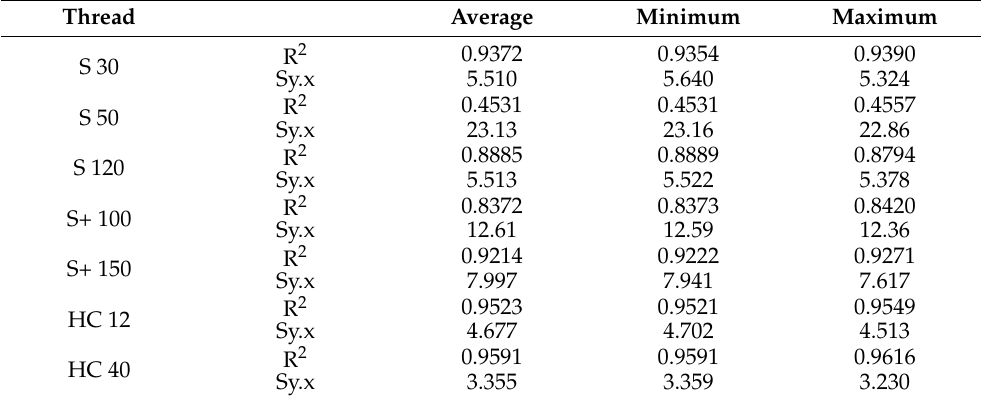
Table 2. Goodness of fit data per fitted line and thread type. Thread